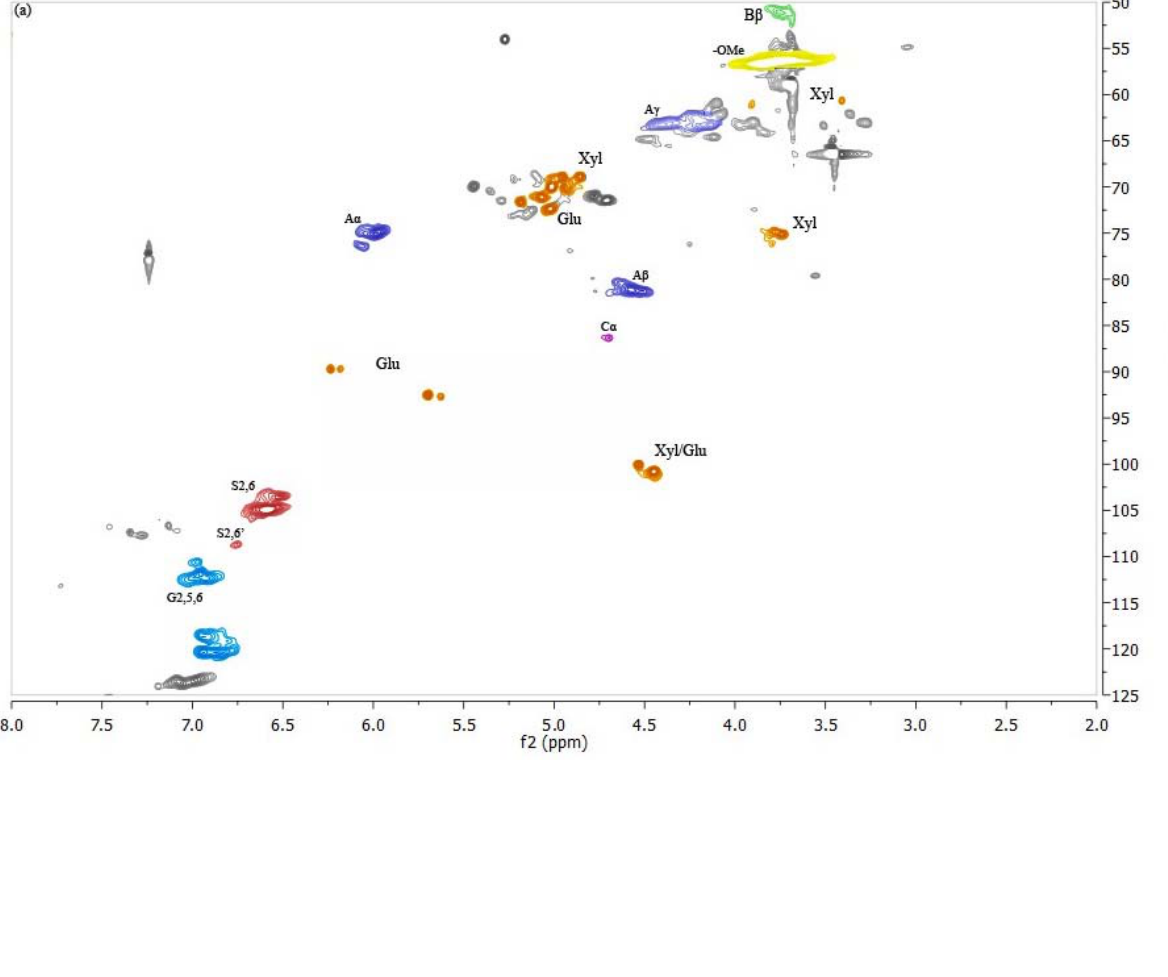
Figure 2. HSQC spectrum of acetylated organosolv lignin in CDCl PTL . Correlations from main lignin structures, and some of the characteristic ( b ) E MK 1 polysaccharide correlations are shown in color. Color coding correlates to the structures shown. Xyl stands for xylose-based polysaccharides; Glu stands for glucose-based